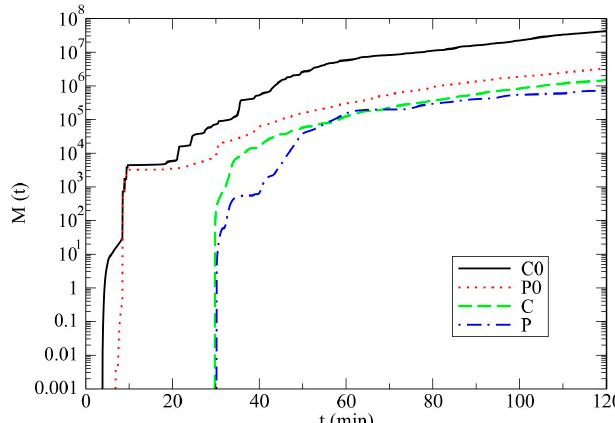
Figure 5. The maximum values of the mean diameter of raindrop spectrum (mm) for clean air without drizzle (C0) and with drizzle (C) and polluted air without drizzle (P0) and with drizzle (P).